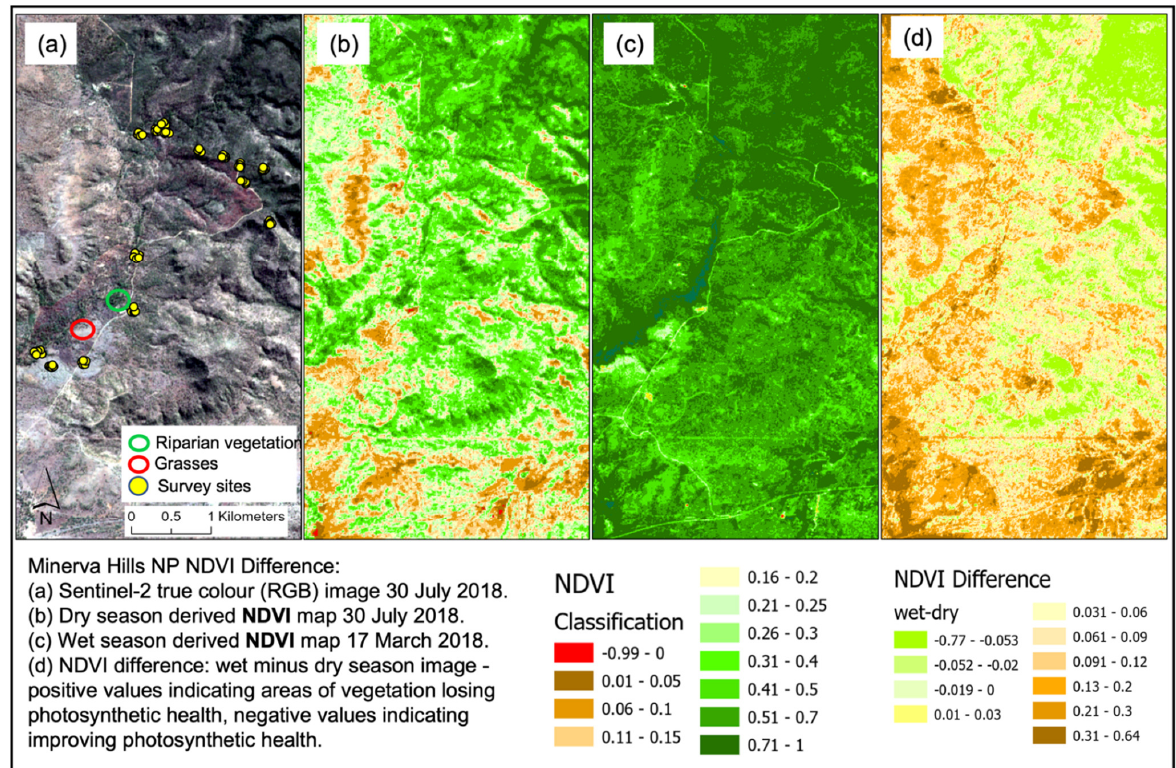
Figure A7. Minerva Hills NP NDVI Difference.